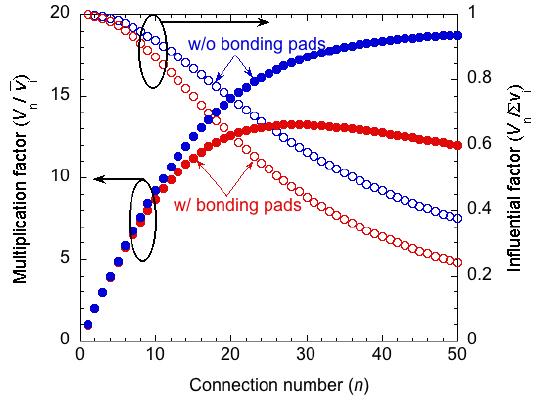
Figure 8. Influence of the parasitic capacitance for piezoelectric elements on a